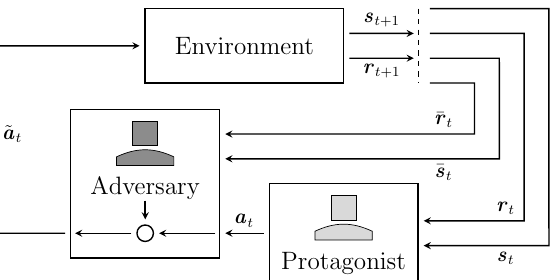
Figure 7. The underlying concept behind action robust designs. The framework considers two different scenarios: (i) The protagonist action is distorted by the adversary through immediate gradient optimization; (ii) A joint action is defined as an linear combination of protagonist and adversarial